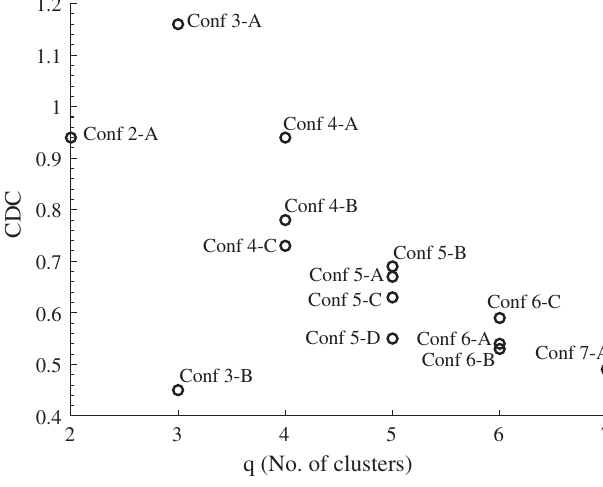
FIG. 9. VRC values for the different cluster configurations obtained by means of H -CLA methods.